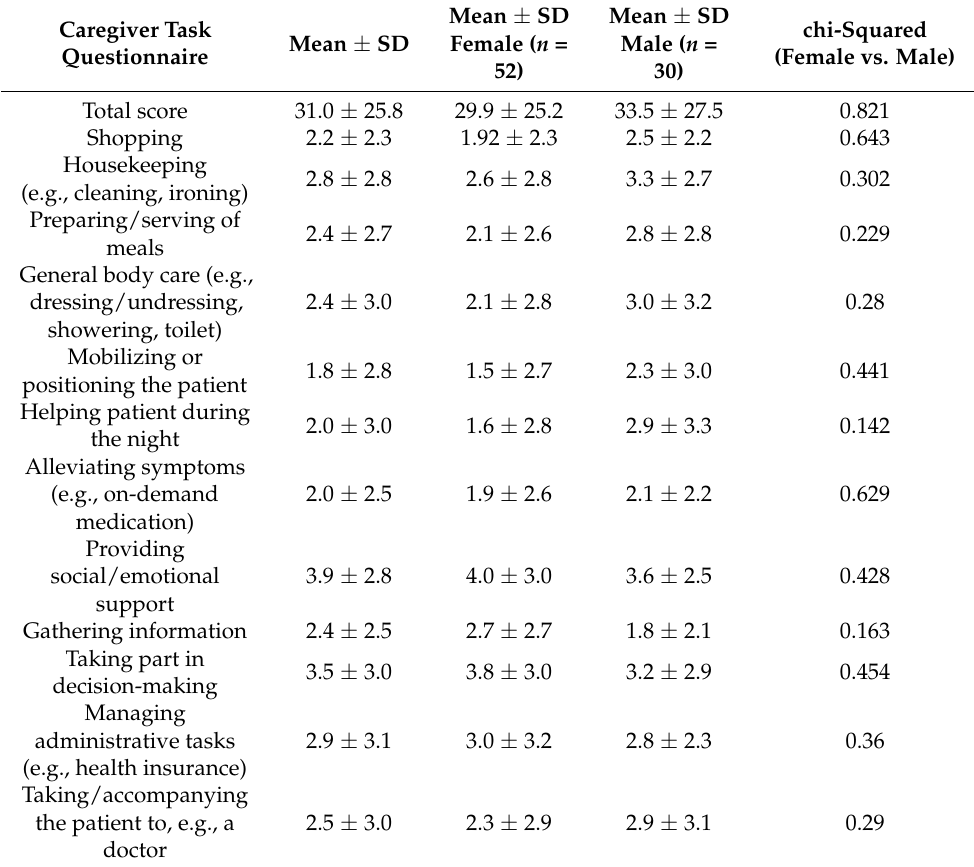
Table 4. Caregiver task